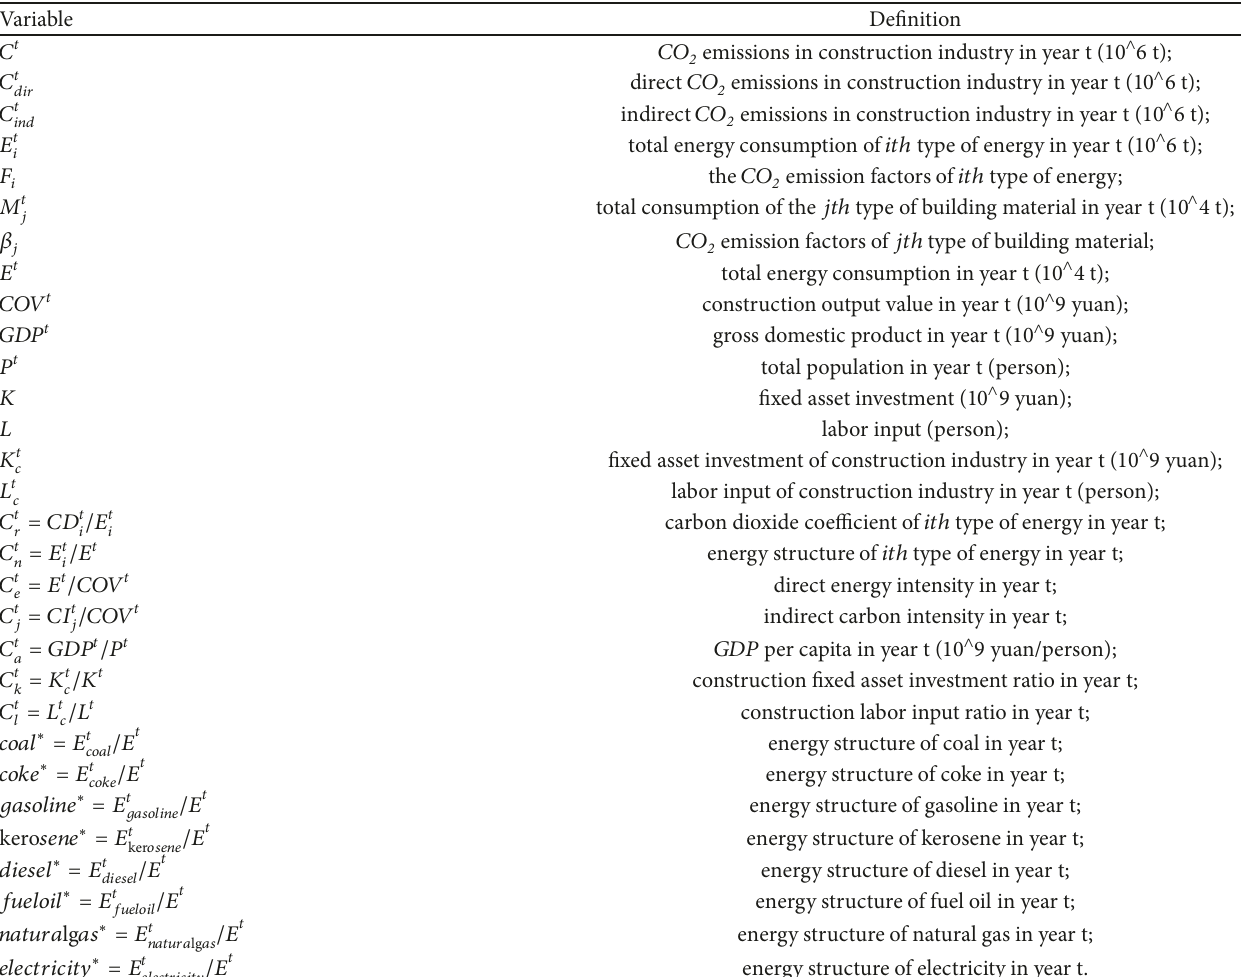
Table 1: Definition of the